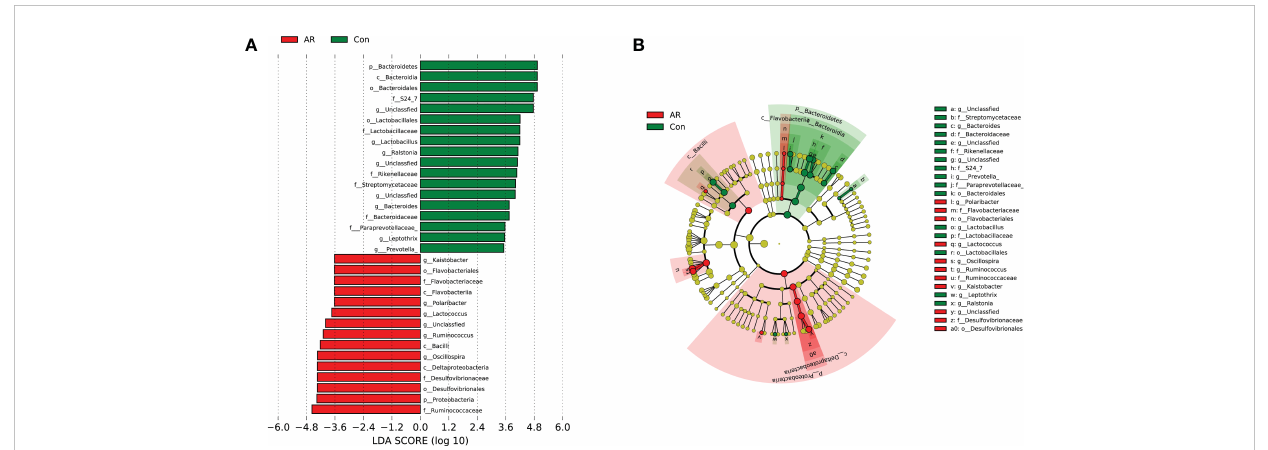
FIGURE 5 LDA scores map and cladogram (LDA fold=3.5 and P < 0.05). The red node in the LDA value distribution histogram represents the microbial groups that play an important role in the AR group, and the green node represents the microbial groups that play an important role in the Con group. Only species with an LDA score > 3.5 are shown in the fi gure. (A) LDA score map. The histogram ’ s length represents the LDA value ’ s size; (B) Cladogram. The circles represent the phylum, class, order, family, and genus from the inside to the outside. Each small circle at different classi fi cation levels represents a classi fi cation at that level. The diameter of the small circle is proportional to the relative